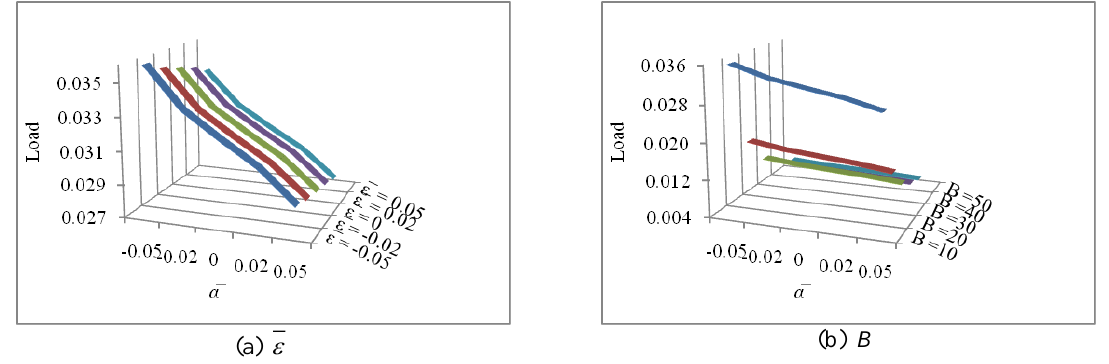
Figure 6. Profile of load bearing capacity with regards to